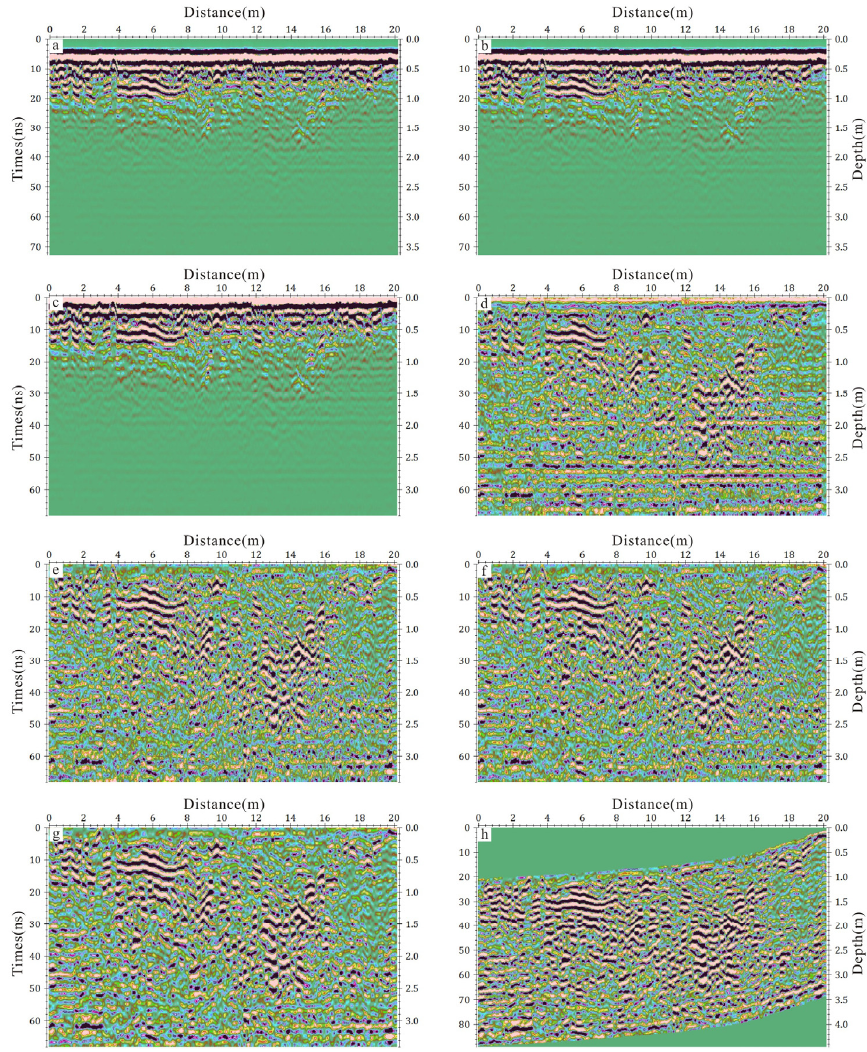
Figure 6. The processing workflow of GPR data. ( a ) The raw GPR data. ( b ) subtract-DC-shift, ( c ) time-zero correction, ( d ) automatic gain control, ( e ) background removal, ( f ) band-pass filter, ( g ) running average filter, ( h ) topographic correction.